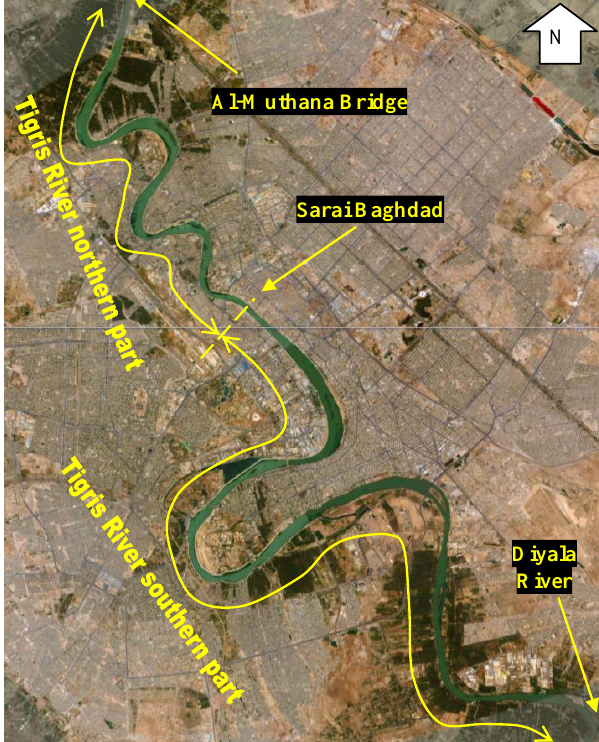
Figure 2. River Tigris within Baghdad City (islands and sandbars border by red) [2].